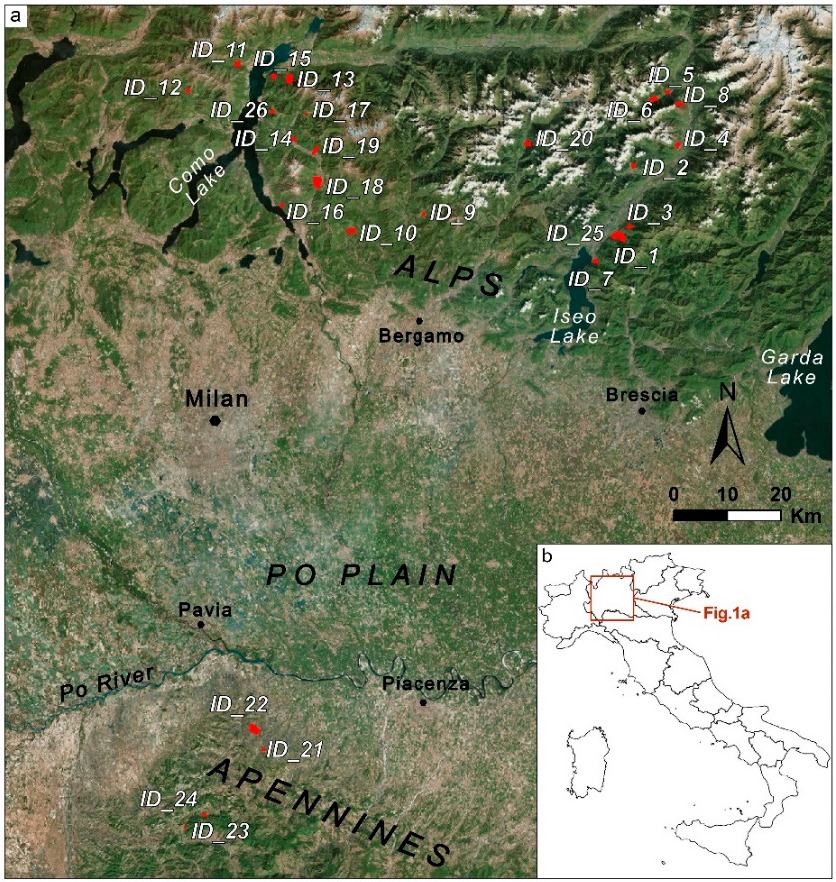
Figure 1. ( a ) Location of the analyzed 26 AOIs. Polygons of the AOIs are in red; ( b ) location of the Figure 1a (red box) in a schematic sketch of